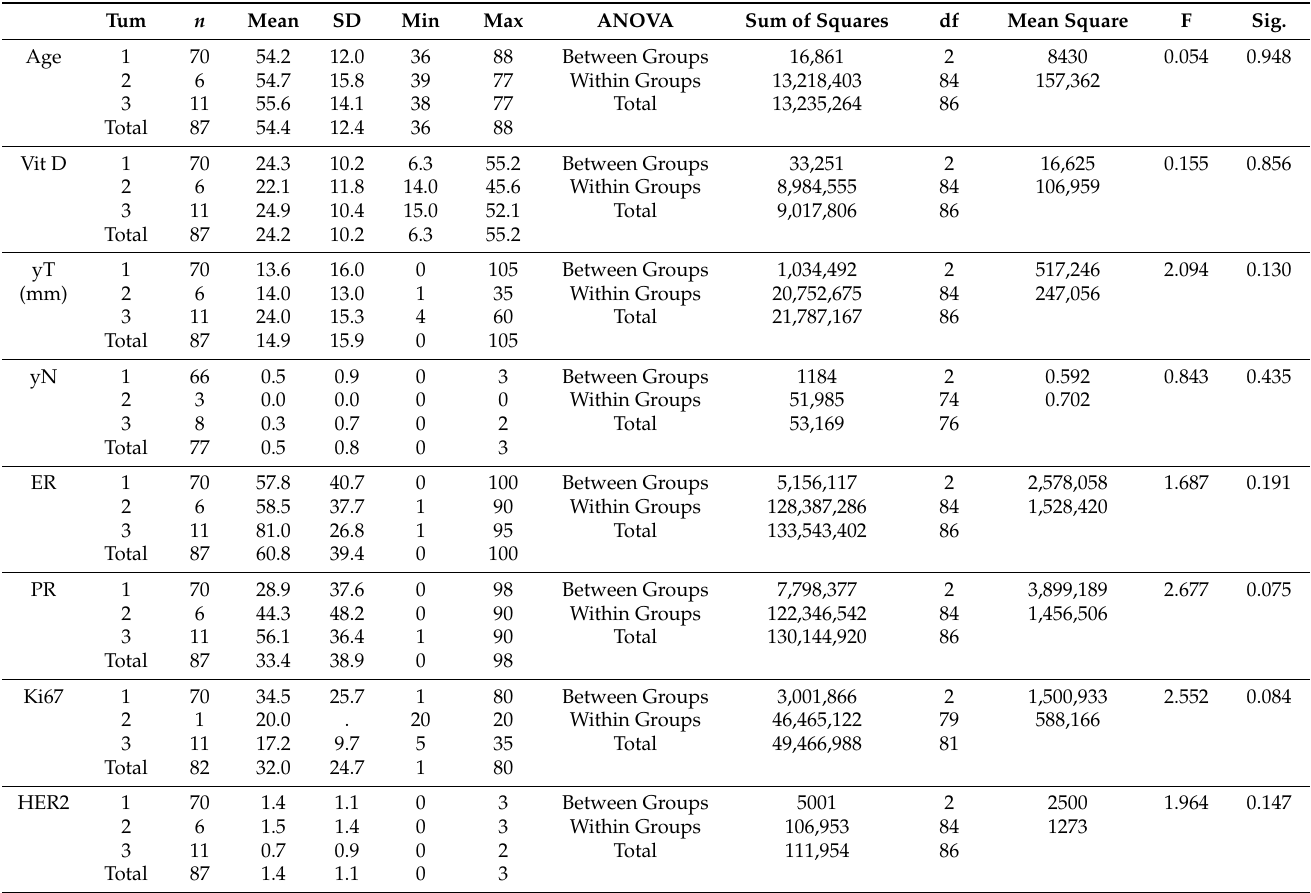
Table 1. Patients’ characteristics and ANOVA correlations between vitamin D levels and tumour type, the type of receptors expressed, and